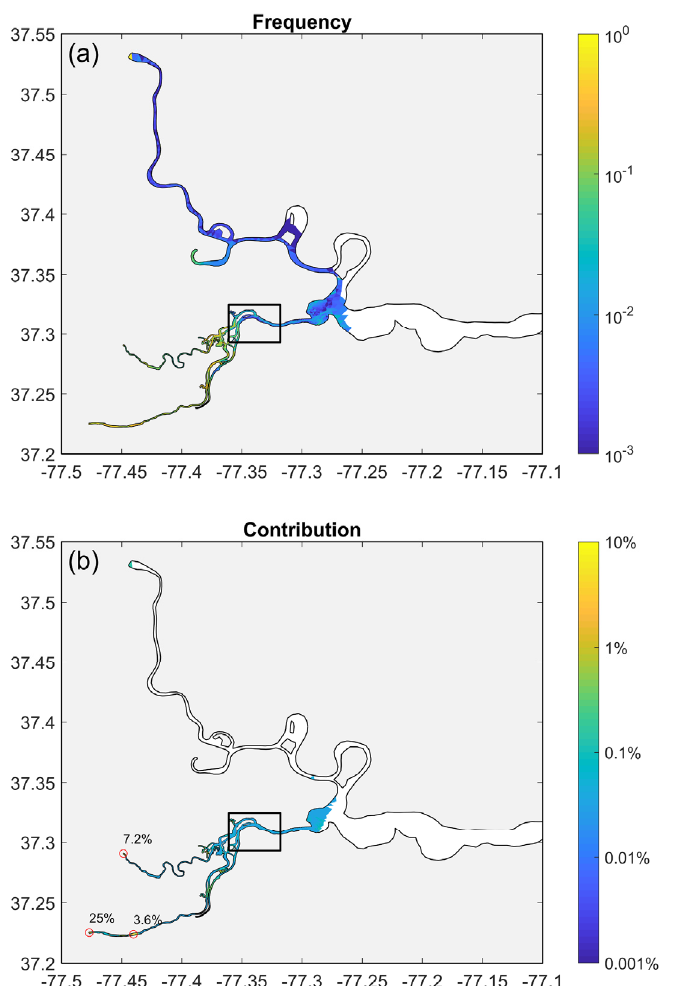
Figure 5. Computed frequency ( a ) and contribution ( b ) of particles released from each location to the particles that encounter the intake during the backward tracking period. The red circles mark the locations with the three highest contributions (=25%, 7.2%, and 3.6%). Note that the location with the highest contribution marked by the red circle (in b) is the location where the freshwater dis- charge enters the Appomattox River in the model.